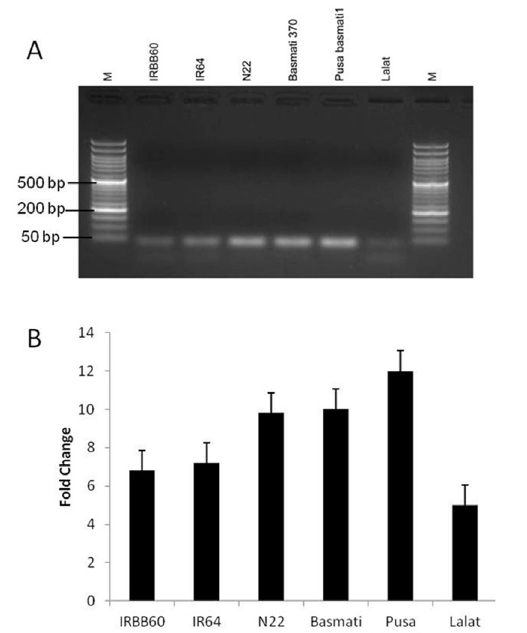
Fig. 2. expression of miRNA 164c in regenerating tissue. A) semiquantitative RT-PCR, B) Realtime PCR